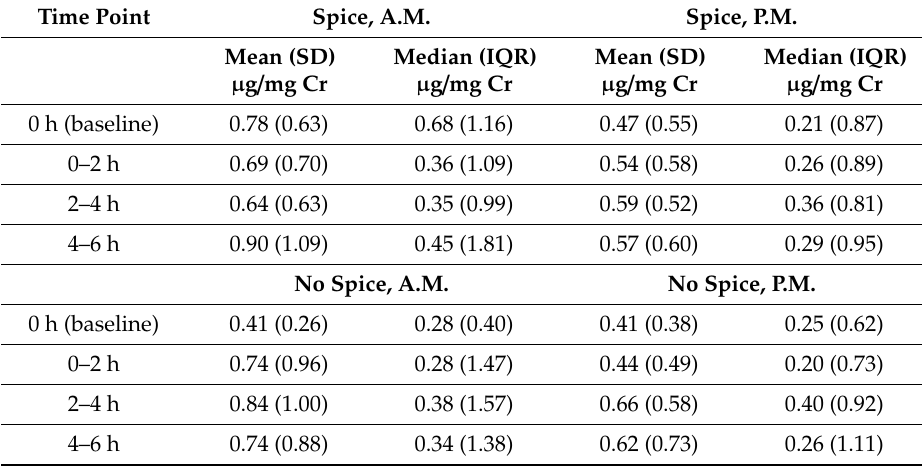
Table 5. Urine malondialdehyde concentrations by treatment and time point. Time Point Spice, A.M. Spice, P.M. Mean